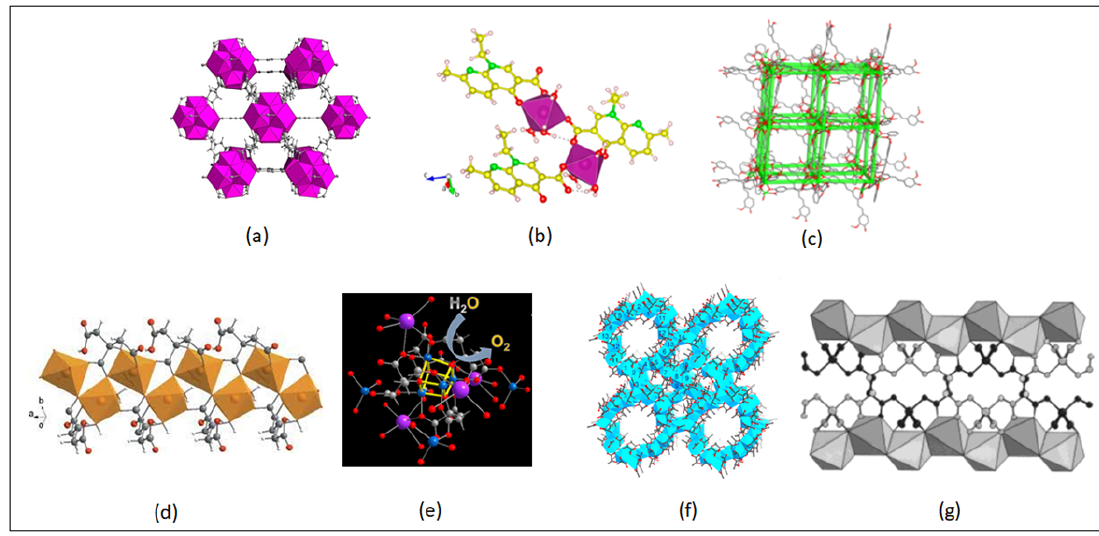
Figure 2. Various types of MOF structures for drug delivery formulations. ( a ) Zr-fumarate.